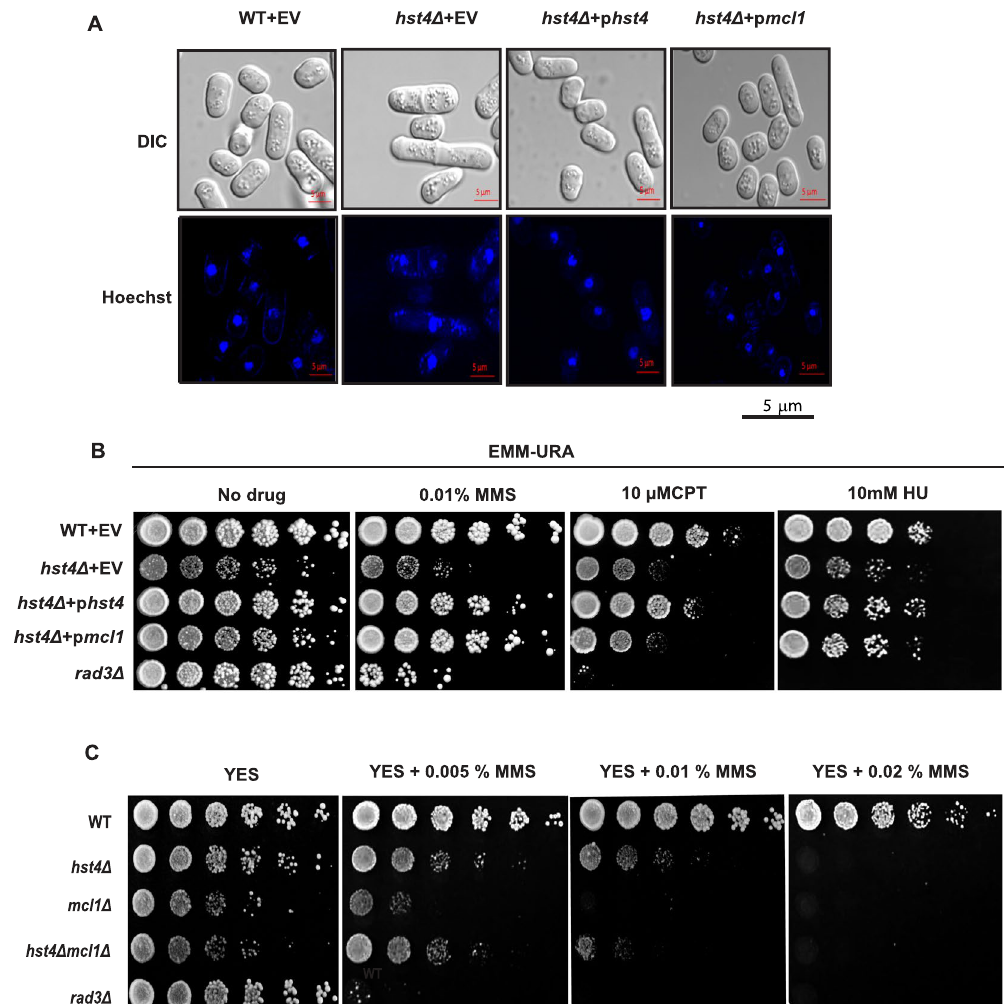
Figure 5. Mcl1 and Hst4 cooperate to promote cell survival following replicative stress. ( A ) Wild type strain (ROP191) or hst4 ∆ (ROP58) expressing hst4 , mcl1 or pSLF272 (empty vector) were grown to stationary phase, DNA was stained with Hoechst and visualized under confocal microscope. Bar = 2 µ m. ( B ) Wild type strain (ROP191) or hst4 ∆ (ROP58) or rad 3 ∆ (ROP266) expressing hst4 , mcl1 or pSLF272 (empty vector) were five- fold serially diluted and spotted on EMM-Ura plates in the presence or absence of 0.01% MMS or 10 mM HU or 10 µ M camptothecin for five days at 30 °C. ( C ) Double deletion mutants of hst4 and mcl1 were generated by crossing hst4 ∆ (ROP58) and mcl1 ∆ (NYSPE19) strains followed by tetrad dissection. Wild type strain (ROP191), hst4 ∆ (ROP58), mcl1 ∆ (NYSPE19), hst4 ∆ mcl1 ∆ (DHP69) and rad 3 ∆ (ROP266) strains were